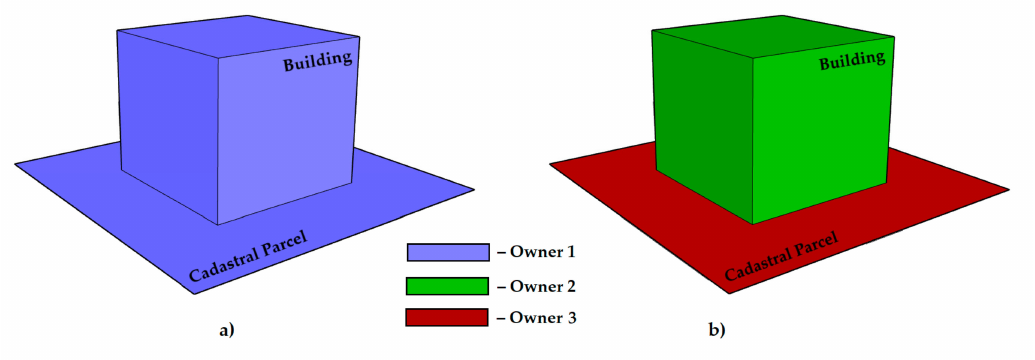
Figure 5. The relationships between cadastral parcel and building. Illustration of physical objects: ( a ) Case 1; ( b ) Case